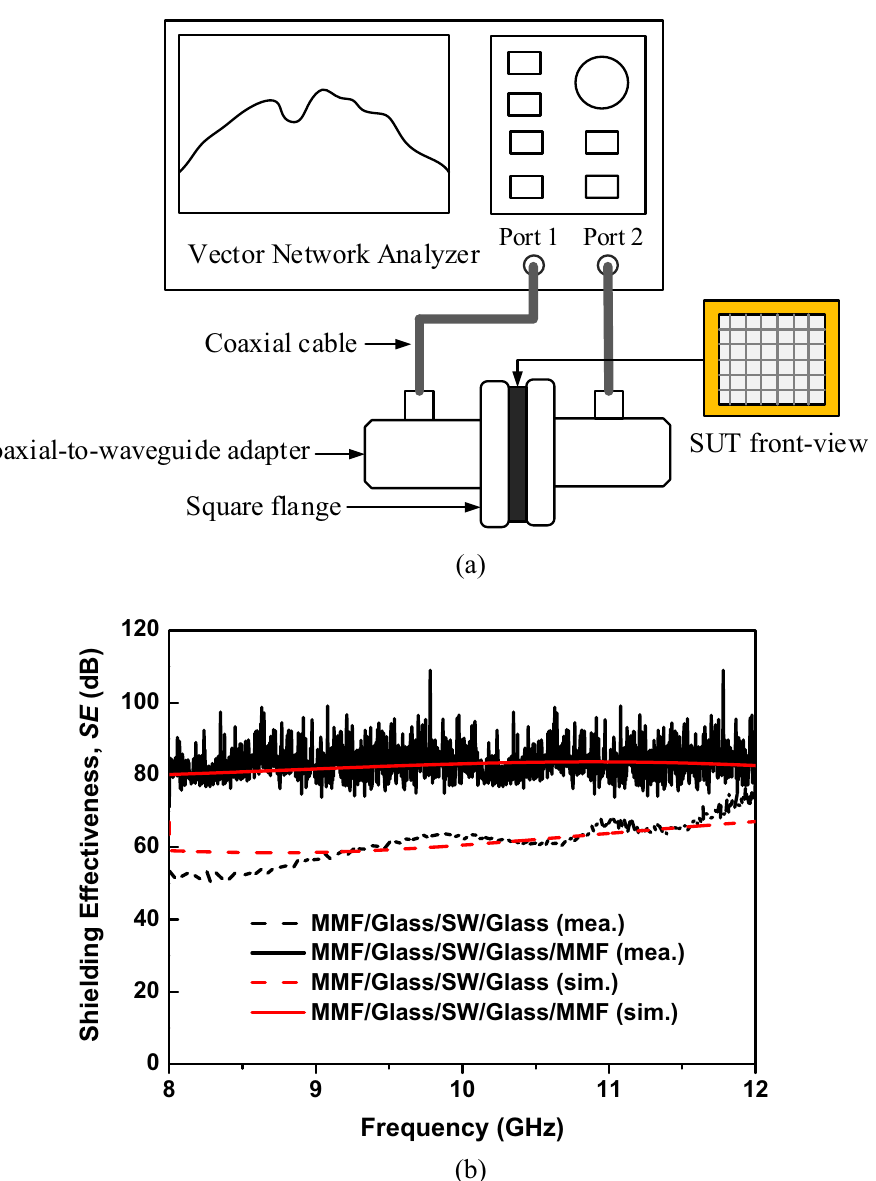
Figure 4. ( a ) Setup for the SE measurement of the structures; ( b ) simulated and measured SE of the saltwater TEs with single and double MMF ( t s = 10 mm).